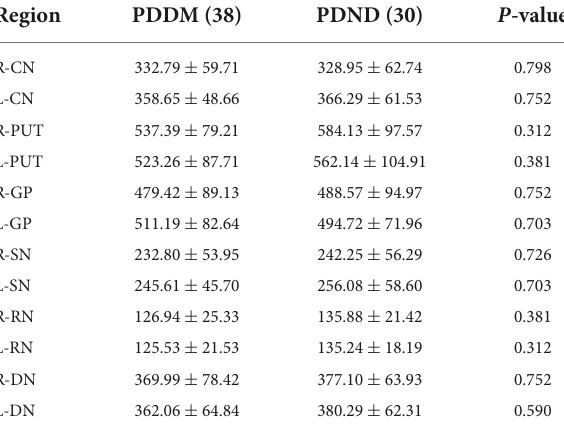
TABLE 5 V W of gray matter nucleus between PDDM group and PDND group.